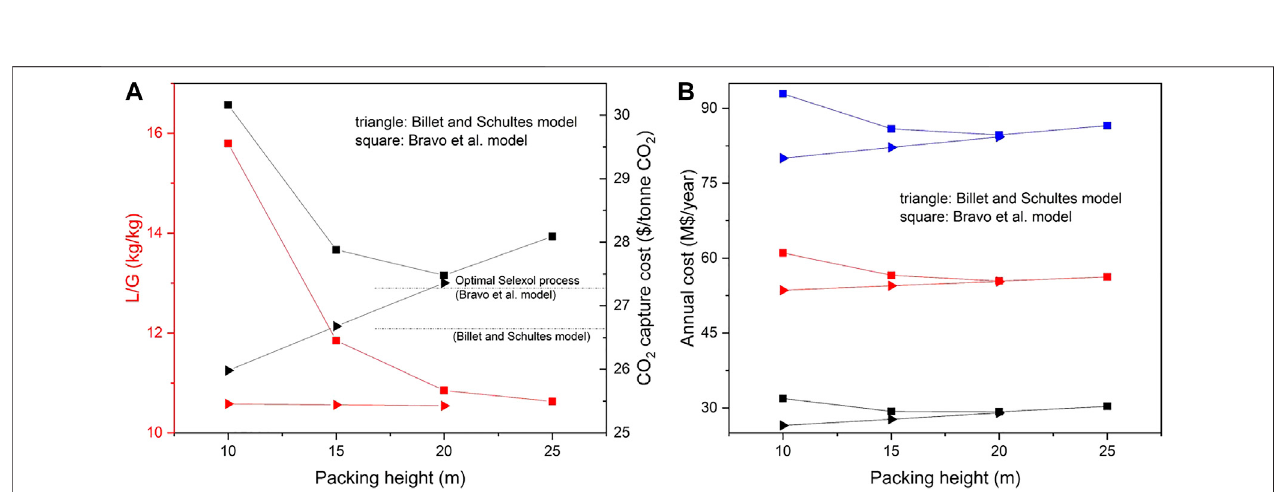
FIGURE4|(A) ThevariationofL/GratioalongwiththepackingheightforATPPB-DEG(1:4).Redlinesandsymbolsrefertotheleftredaxis,blacklinesandsymbols refer to the right black axis; (B) The variation of CO 2 capture cost along with the packing height for ATPPB-DEG (1:4). Black/red/blue samples and symbols refer to capital/operating/total annual cost,